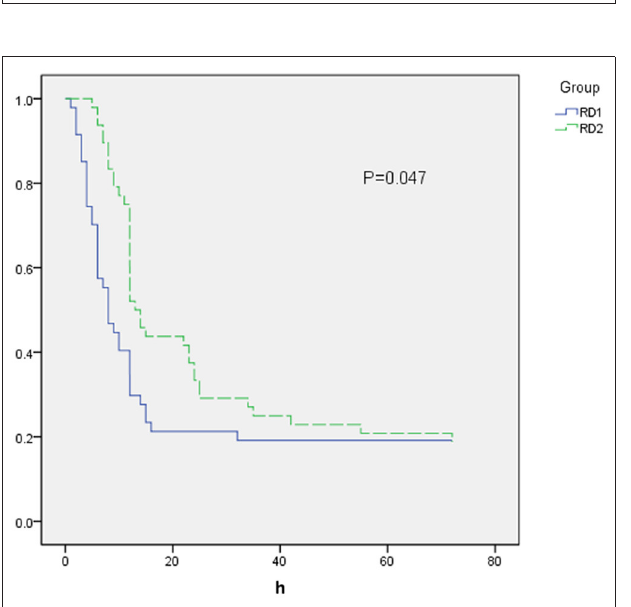
FIGURE 6 | Time to first rescue analgesia.